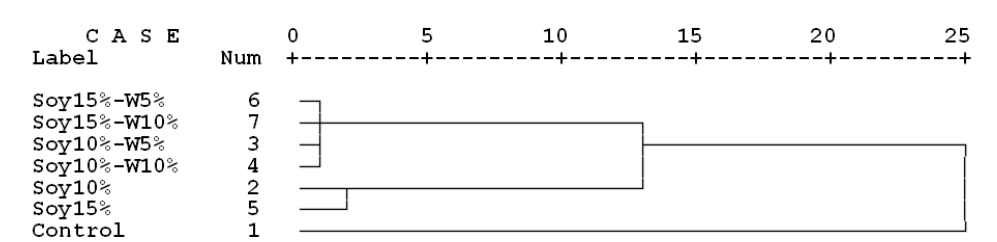
Figure 11. Cluster analysis of seven different three-layer plywood panels produced with urea-formaldehyde resin, and 10% and 15% soy flour substitution for UF resin, plus addition of wollastonite at 5% and 10% (Soy% = soy flour content; W% = wollastonite content).